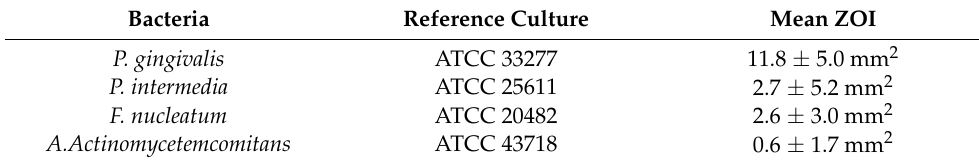
Table 4. Antibacterial effect of periodontal pathogens